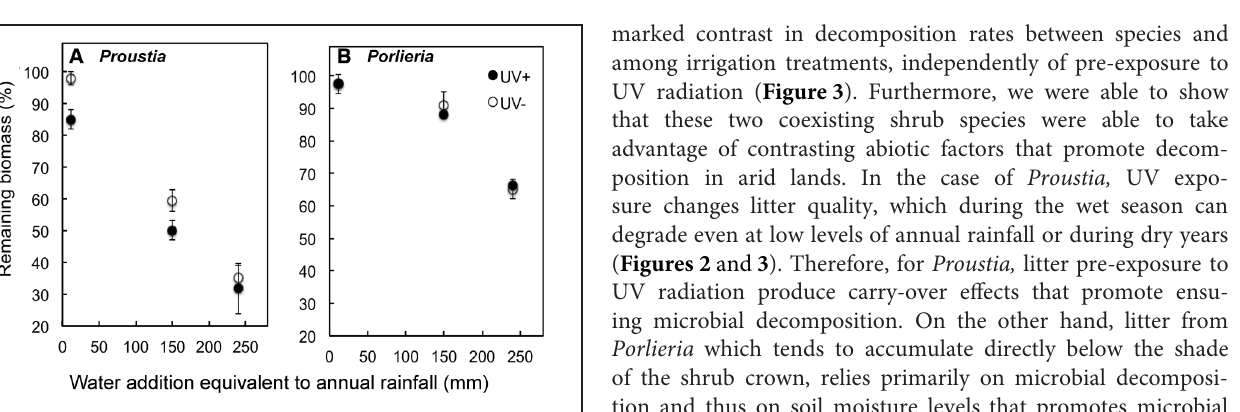
FIGURE 2 | Remaining litter biomass (%) at the end of a 6-month decomposition experiment, preceded by photodegradation in the field. Samples from the field experiment are shown by open (UV + ) or filled symbols (UV − ). The laboratory experiment included irrigation treatments representing years with contrasting annual rainfall. Irrigation treatments represented the equivalent rainfall of a dry year (˜15 mm), an average year (140 mm) and wet (El Niño) year (240 mm) in semiarid Chile. The experiment was conducted under constant temperature (23 ◦ C). (A) Remaining litter biomass Proustia and (B) Porlieria . Data are means ± 1